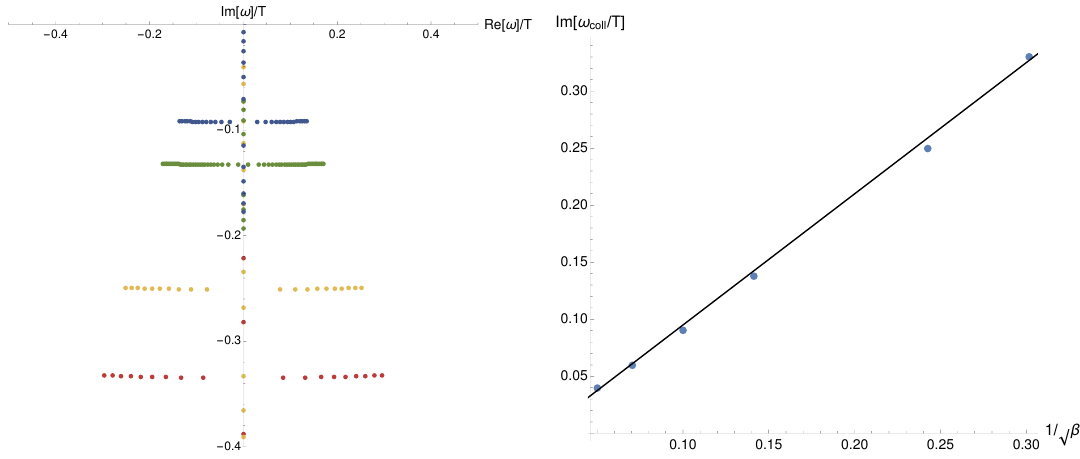
Figure 12 . Left: lowest QNMs for three di(cid:11)erent values of (cid:12) = 11 ; 17 ; 50 ; 100 (red-blue) increasing m=T in the vicinity of the collision. Right: value of the frequency at the collision as a function of (cid:12) = h SSB i = h EXB i